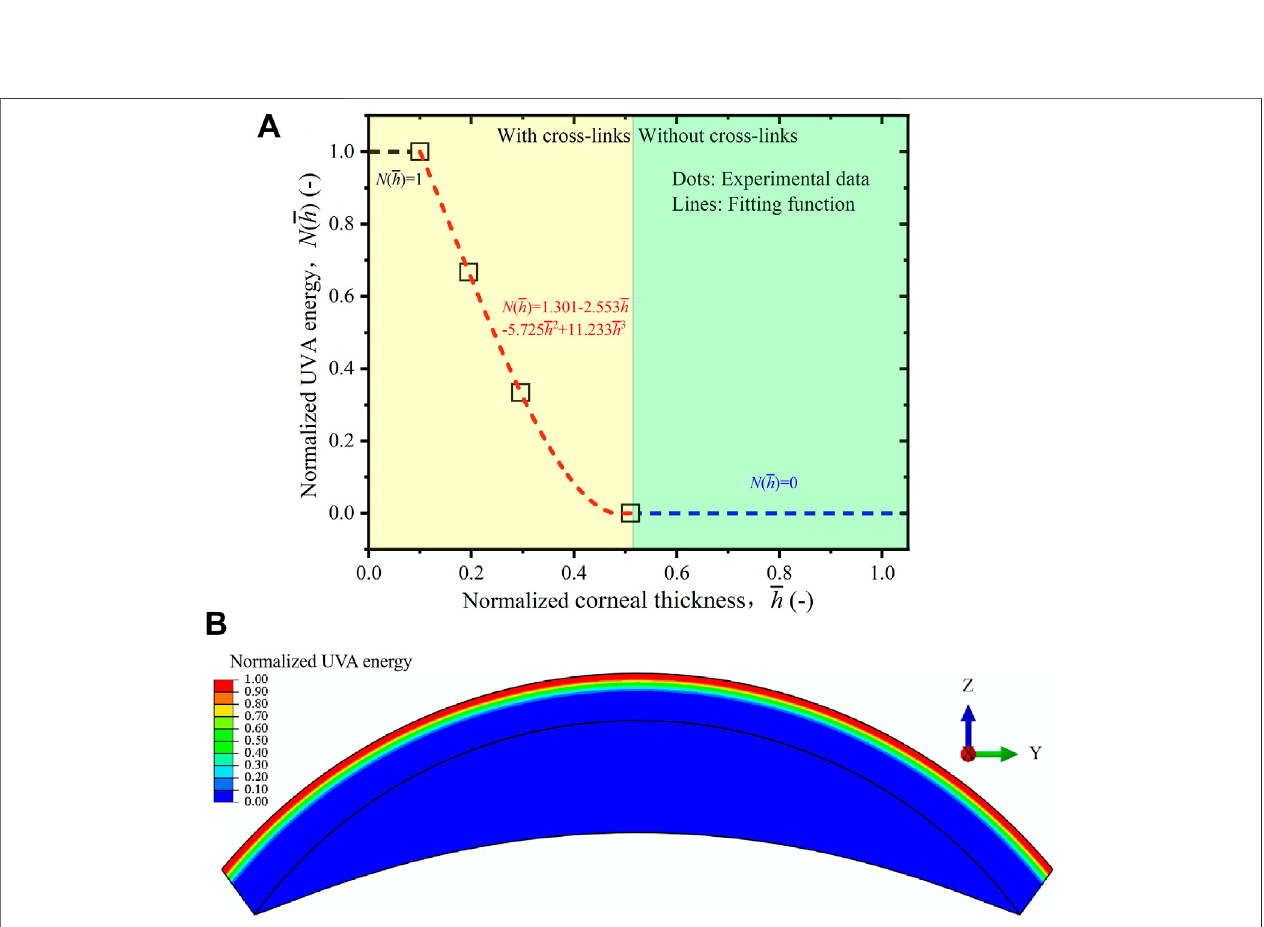
FIGURE 3 | (A) Normalized UVA energy compared between the experimental data (Liu et al., 2020b) and fi tting function. (B) Numerical distribution of the normalized UVA energy function in ABAQUS.